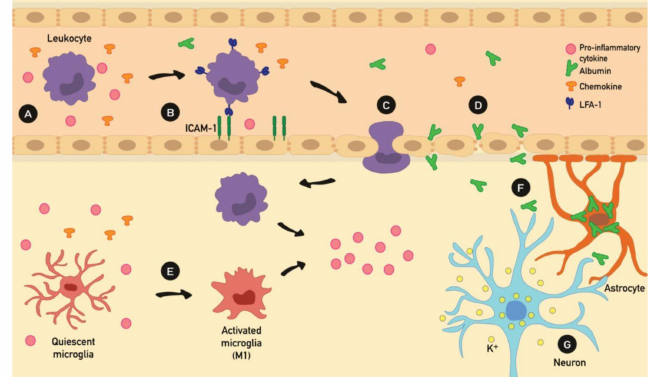
Figure 2. Cascade of events during inflammation-mediated seizures. ( A ) An initiating inflammatory challenge causes an increase of proinflammatory mediators such as cytokines and chemokines, ( B ) which in turn leads to an upregulation of leukocyte ligands (e.g., LFA-1) and endothelial counterligands (e.g., ICAM-1), eventually resulting in leukocyte recruitment. ( C ) Upregulation of adhesion molecules reflected in leukocyte migration into the brain parenchyma and ( D ) a morphological change in the endothelial cells’ shape, finally resulting in an alteration of tight junctions; these processes will lead to blood–brain barrier (BBB) leakage with the extravasation of serum components (e.g., albumin). ( E ) Microglial cells are consequently activated by proinflammatory cytokines. ( F ) Moreover, the albumin extravasation induces a decrease of inward-rectifying K + channels in astrocytes, leading to an increase of extracellular potassium in brain parenchyma. ( G ) Therefore, the higher extracellular K + level facilitates neuronal hyperexcitability and induces seizure